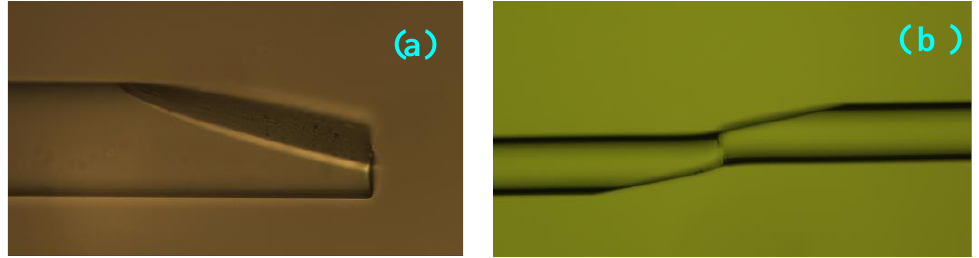
Figure 3. ( a ) Image of the vitreous-clad multi-mode fiber with a grinded tapered angle; ( b ) Image of a fused probe with an inclined plane structure.